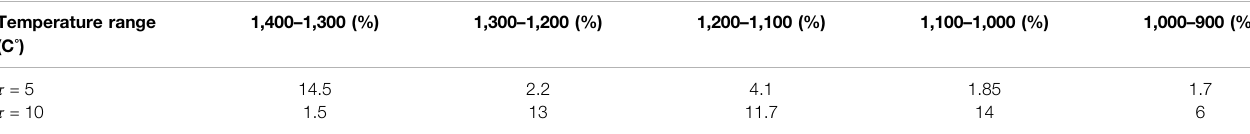
TABLE 2 | Error in temperature prediction between ED and HL models for different temperature domains. The laser power and speed are 200 W and 1,000 mm/s, respectively ( Figure 12B ). Temperature range (C °